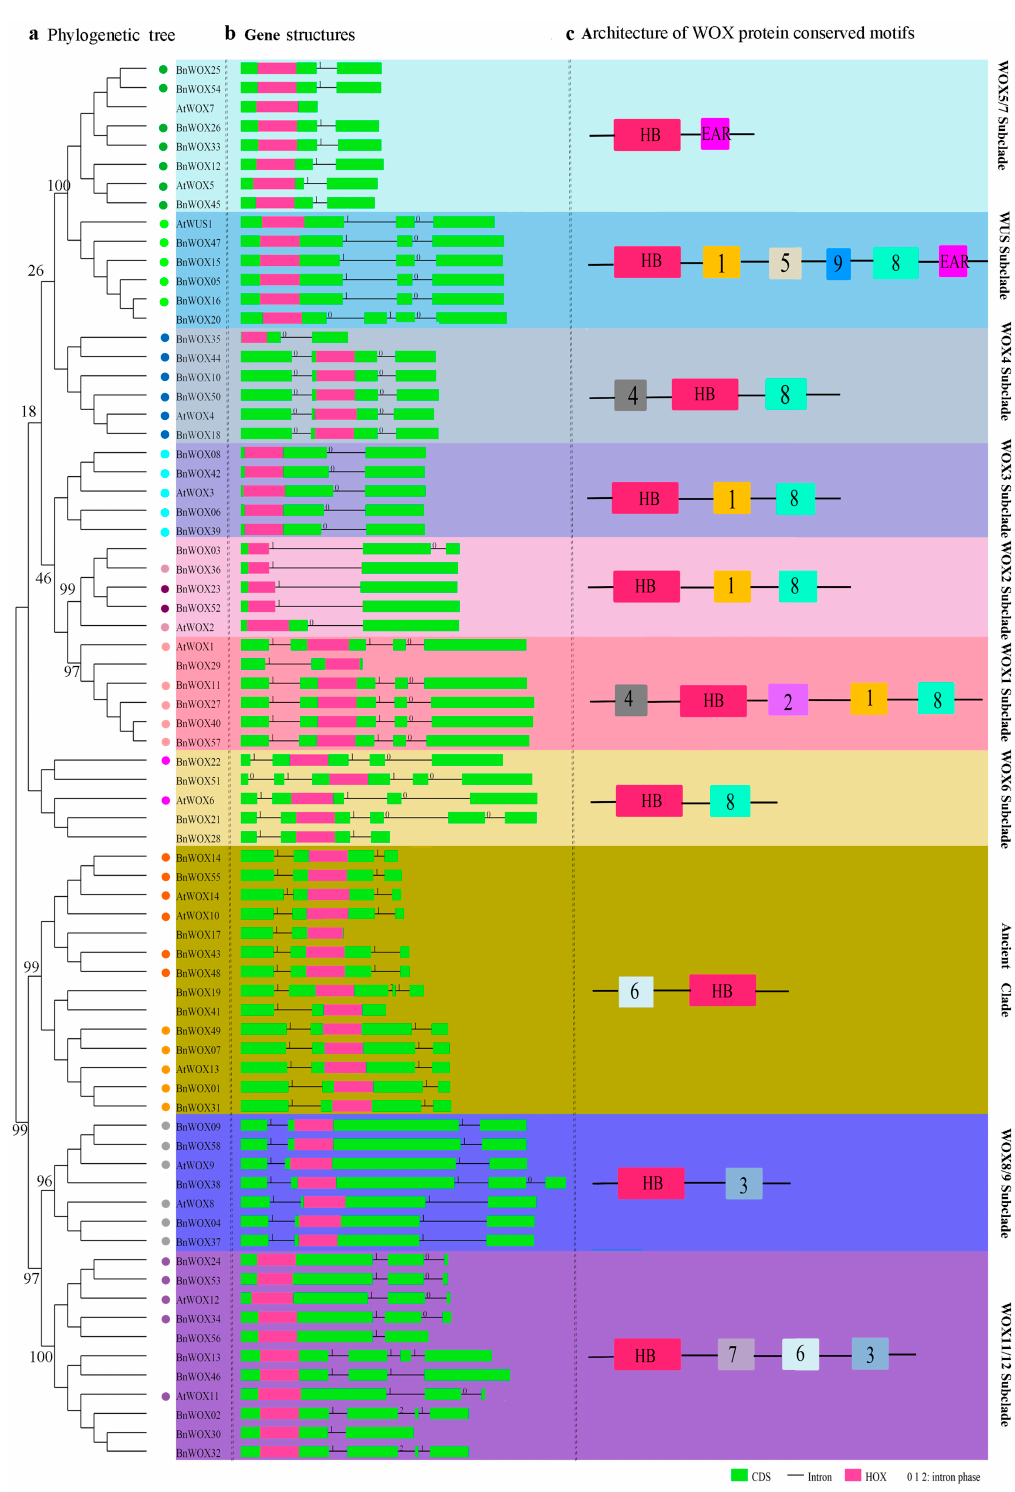
Figure 3. Gene structure and conserved motifs in WOX s from Arabidopsis and B. napus . ( a ) The neighbor-joining tree was generated from the alignment of 73 WOX genes from Arabidopsis and B. napus . The different background colors represent the nine subclades, which are supported by high bootstrap values. The colored dots indicate the 12 conserved intron insertion patterns. ( b ) Gene structures were generated using the Gene Structure Display Server (GSDS 2.0) [25]. Green boxes indicate exons; black lines indicate introns and pink boxes represent the HB domains. Numbers 0, 1 and 2 represent intron phases. ( c ) Conserved motifs were detected using MEME and are shown as boxes of different colors. Motif sequences are provided in Table